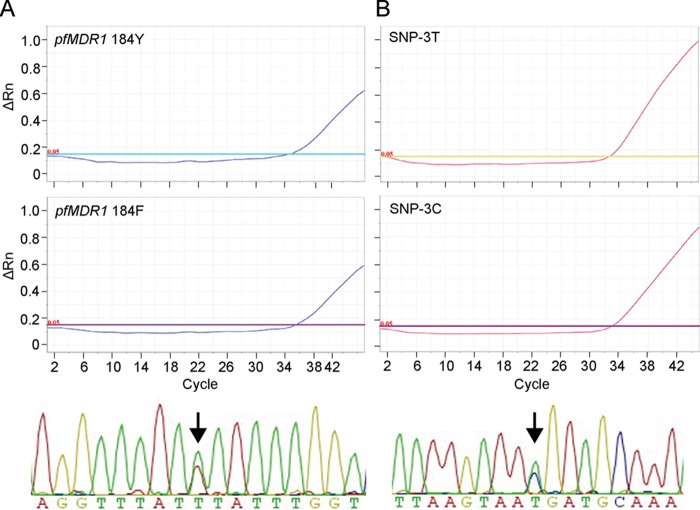
Examples of heteroresistance and mixed infection as determined by the malaria TAC. The DB133 and DB009 samples were detected as mixed alleles by the malaria TAC and then sequence confirmed. (A) TaqMan probe-based amplification plots are shown for the wild-type probe (pfMDR1 184Y) and mutant probe (pfMDR1 184F); Sanger sequencing shows mixed T/A residues (arrow), indicating mixed F(TTT) and Y(TAT) alleles for the DB133 sample (bottom panel). (B) TaqMan probe-based amplification plots are shown for the major and minor allele probes for SNP3 (Pf_02_000842803 (T) and Pf_02_000842803 (C); Sanger sequencing shows mixed T/C residues for the DB009 sample (arrow).